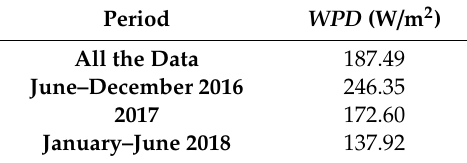
Table 6. Wind power